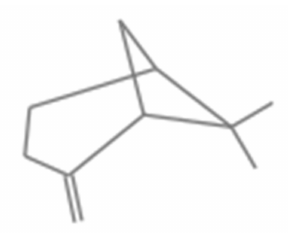
Figure 5. Chemical structure of β -pinene.